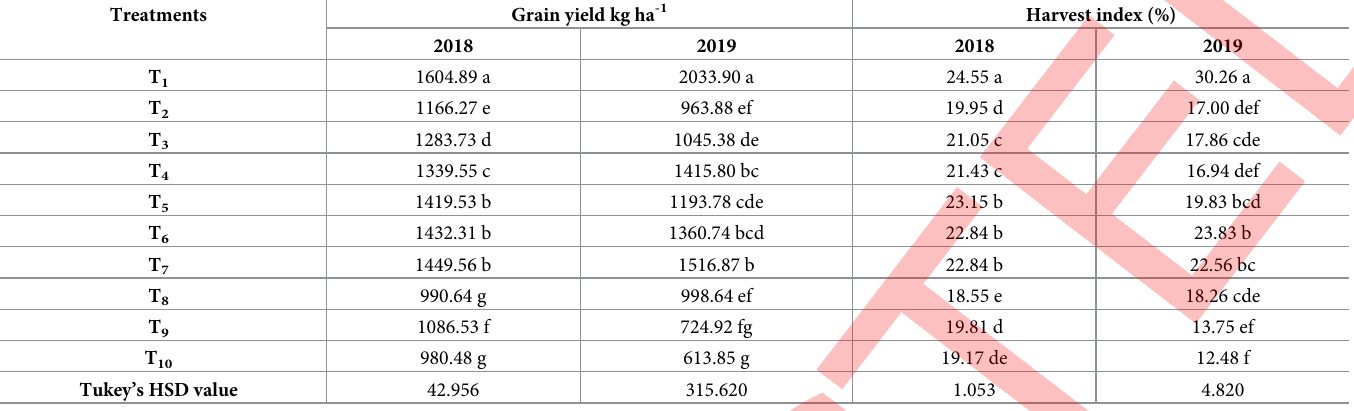
Table 2. The impact of horse purslane and other weeds’ interference on grain yield and harvest index of soybean crop. Treatments